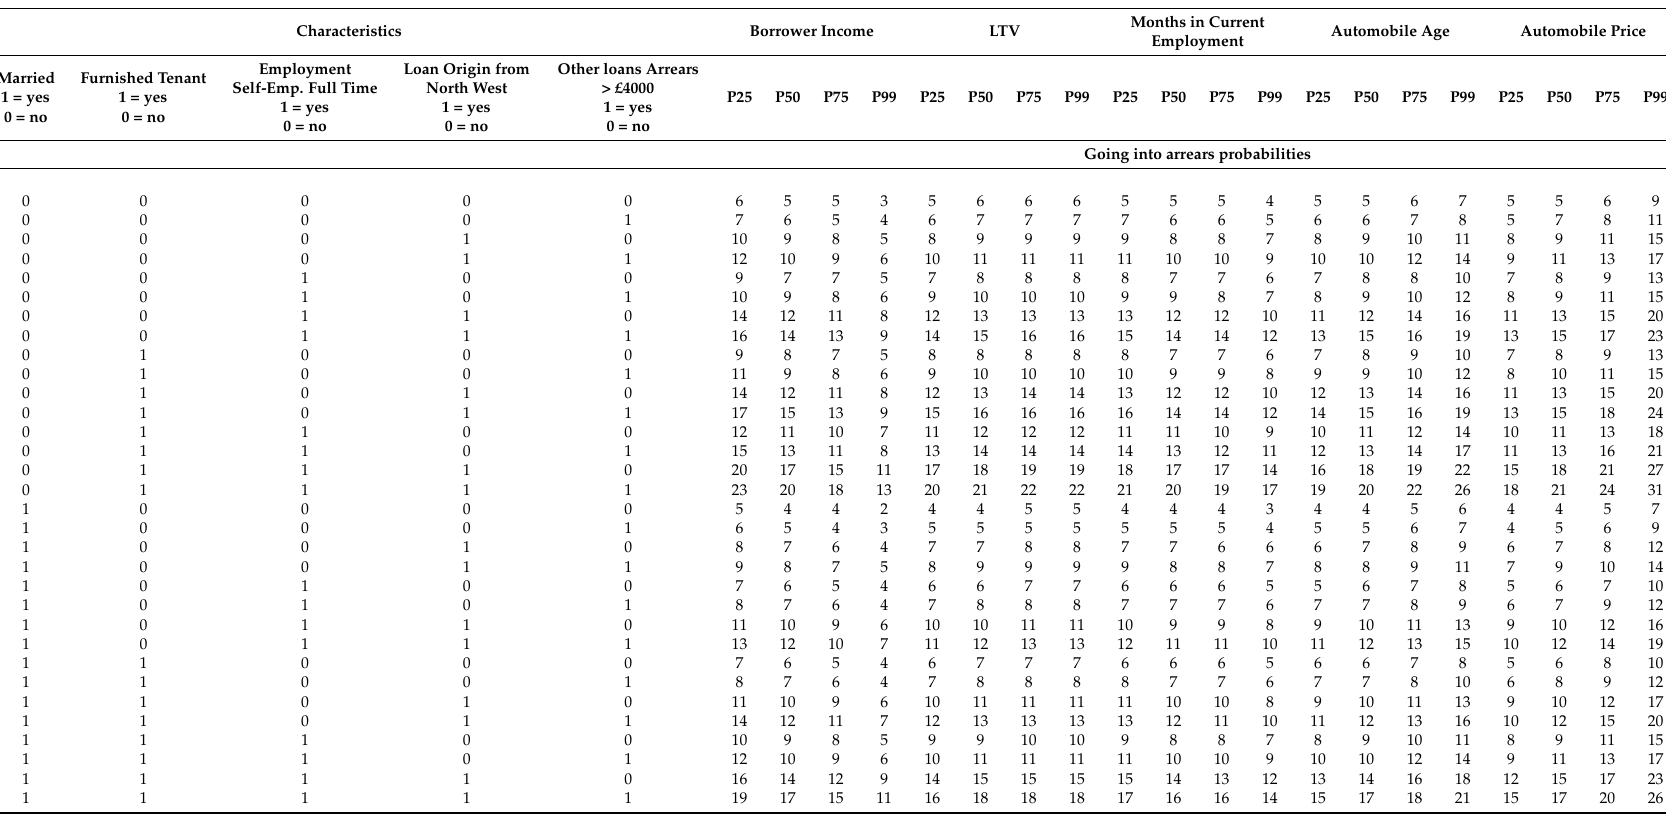
Table 7. Subprime borrower’s demographic, residential and employment status, loan origination area, other loans arrears and predicted going into arrears